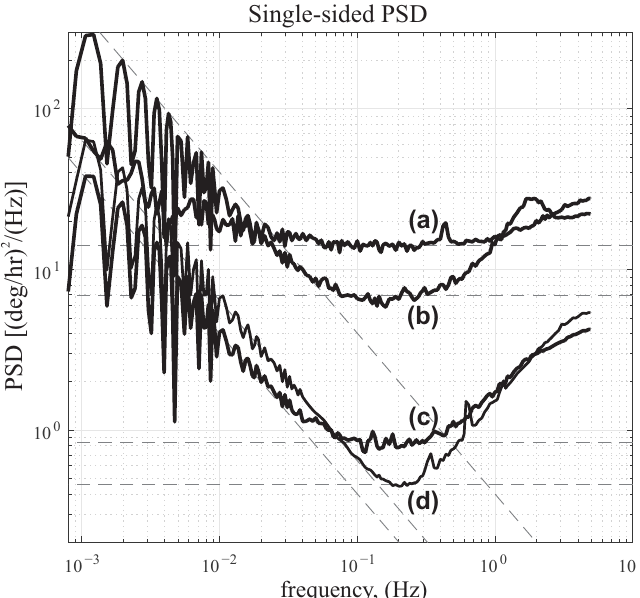
Figure 21. Rate PSD of static QMG data with curve fit lines estimating ARW (slope 0) and bias (slope –1). Lines ( a – d ) represent the same dataset and labelled in the time-domain analysis of Figure 20. Data sample rate is